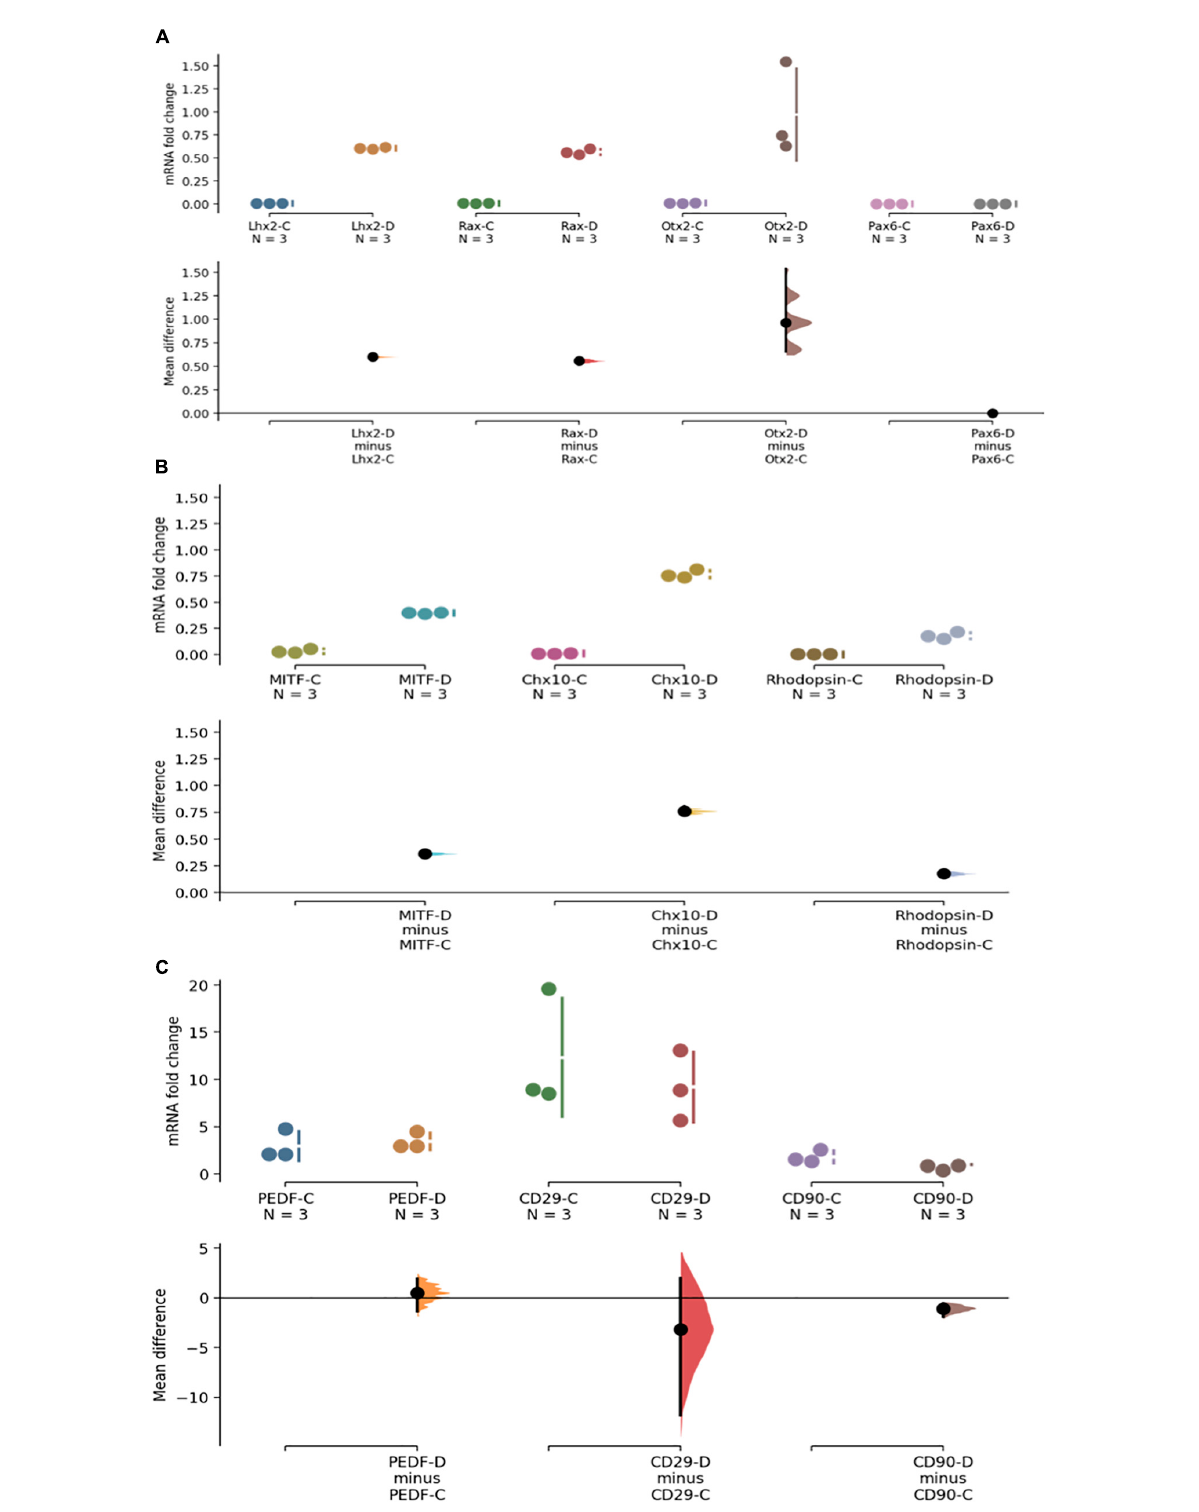
FIGURE4 PhDPSC cultured in retinal differentiation conditions –D continue to express high levels of mesenchymal markers despite acquisition of retinal progenitor and retinal subtype specific precursor markers. (A) Top panel shows up-regulation of mRNA expression of retinal progenitor